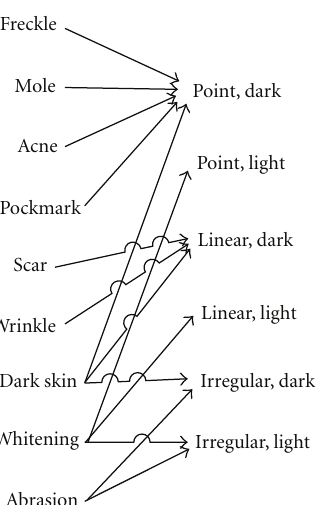
Figure 9: Classification of facial marks to the morphology and color based